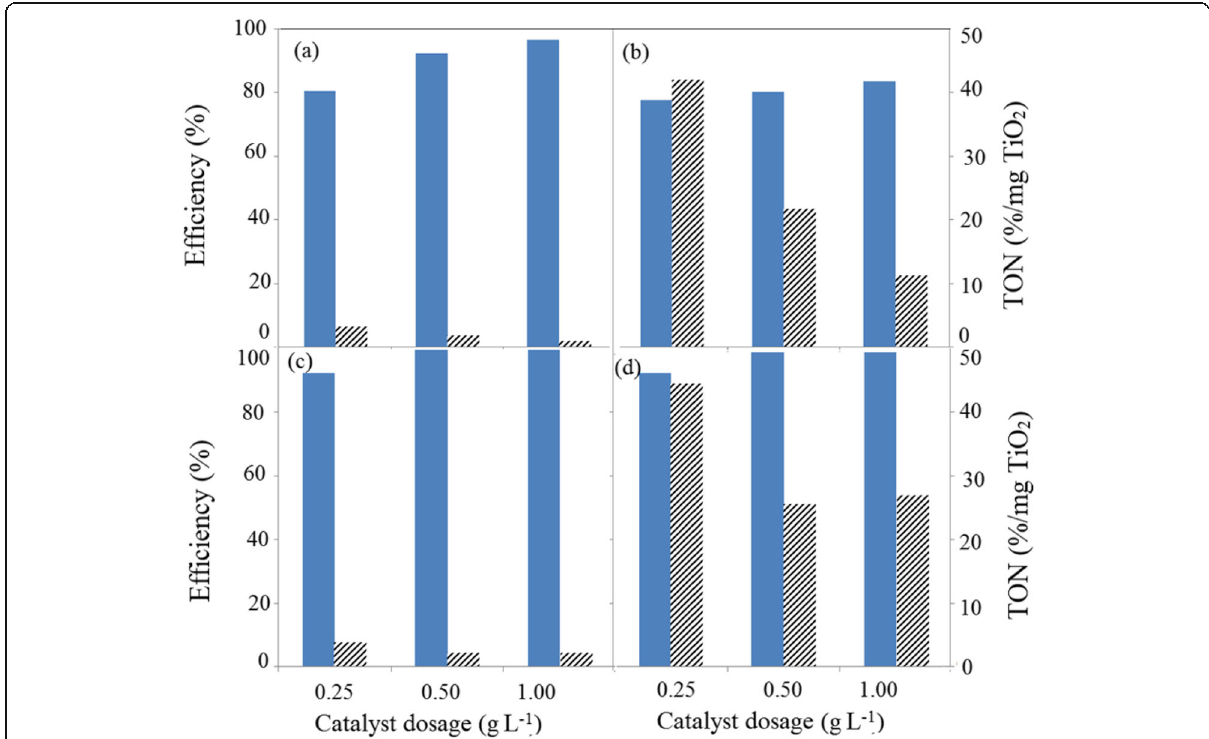
Fig. 9 Degradation efficiency and TON at varied photocatalyst dosage of ( a ) photooxidation using TiO 2 , ( b ) photooxidation using HAp- n TiO 2 , ( c ) photocatalysis using TiO 2 , and ( d ) photocatalysis using HAp- n TiO 2 [Initial MV concentration = 25 mg L − 1 , H 2 O 2 = 10 − 4 M, TON values are calculated from 30 min of